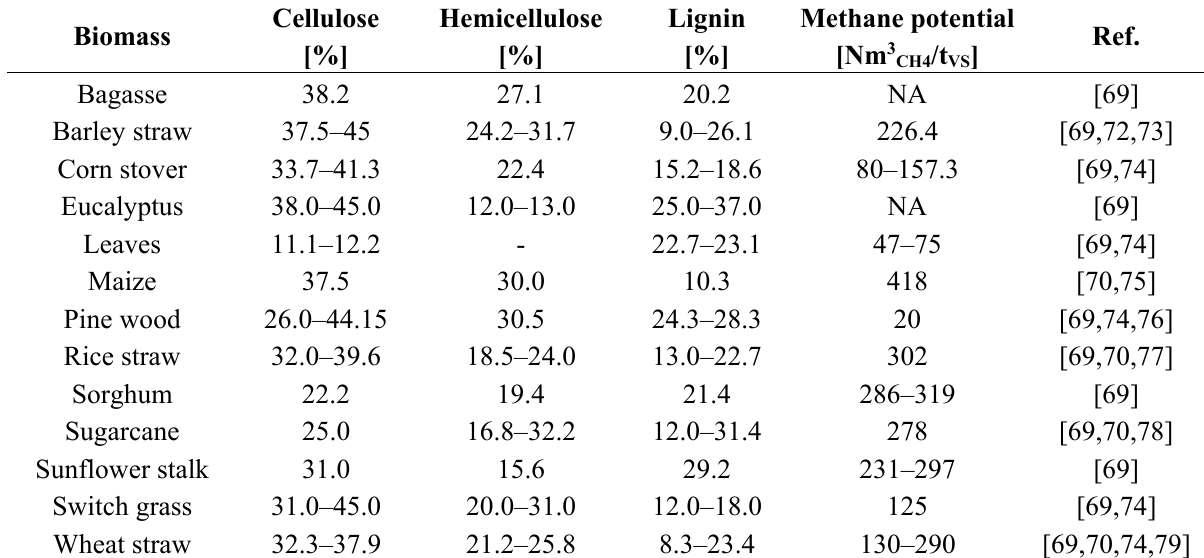
Table 2. Composition and methane yields of selected kinds of